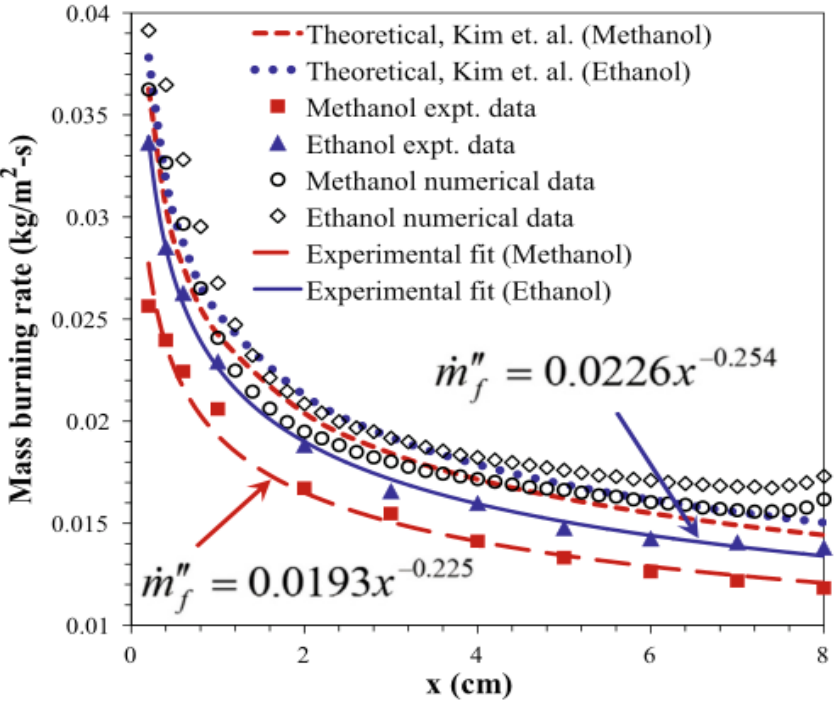
Figure 11. Change of the local MBR on methanol and ethanol Figure 15. Change of the local MBR on methanol and ethanol [115].